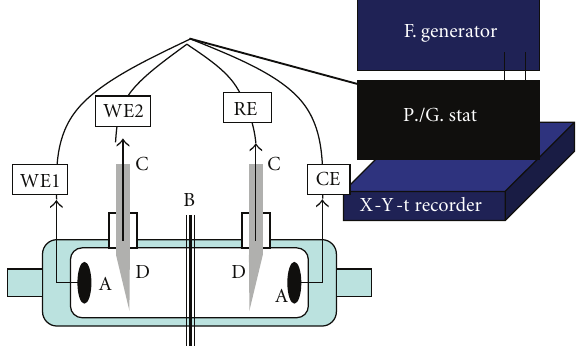
Figure 1: Experimental cell with electrochemical apparatus. A; Ag/AgCl electrode. B: Membrane system (Monopolar or Monopo- lar+Mosaic membranes). Membranes parts are fixed by two rubbers with holes, 1cm in diameter from both sides to avoid the leak of solution. C: Ag/AgCl electrode. D: 3 M KCl in